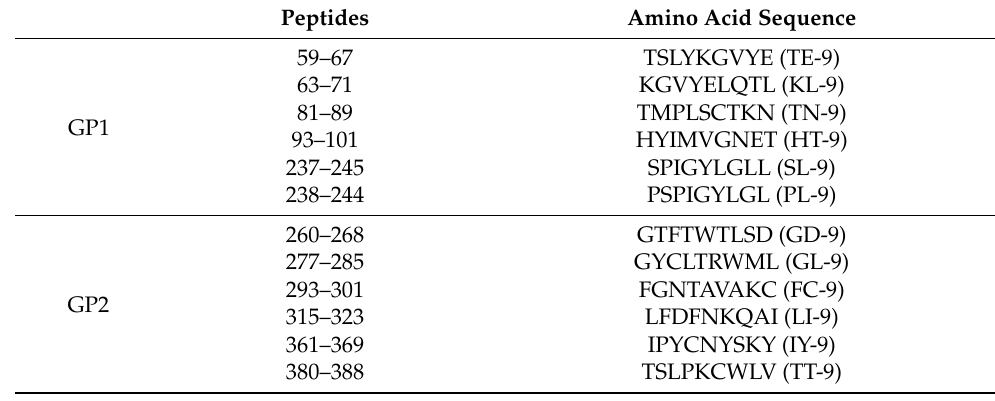
Table 2. The predicted H-2 d -restricted CD8 + T-cell epitopes in LASV GPC.